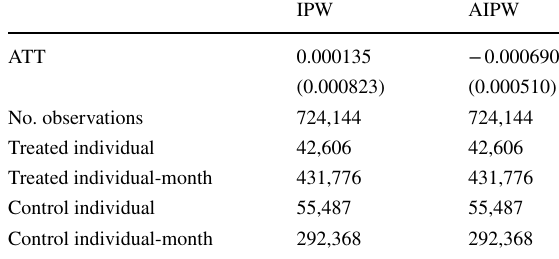
Treated group: unemployed MIS recipients. Control group: unem- ployed people without